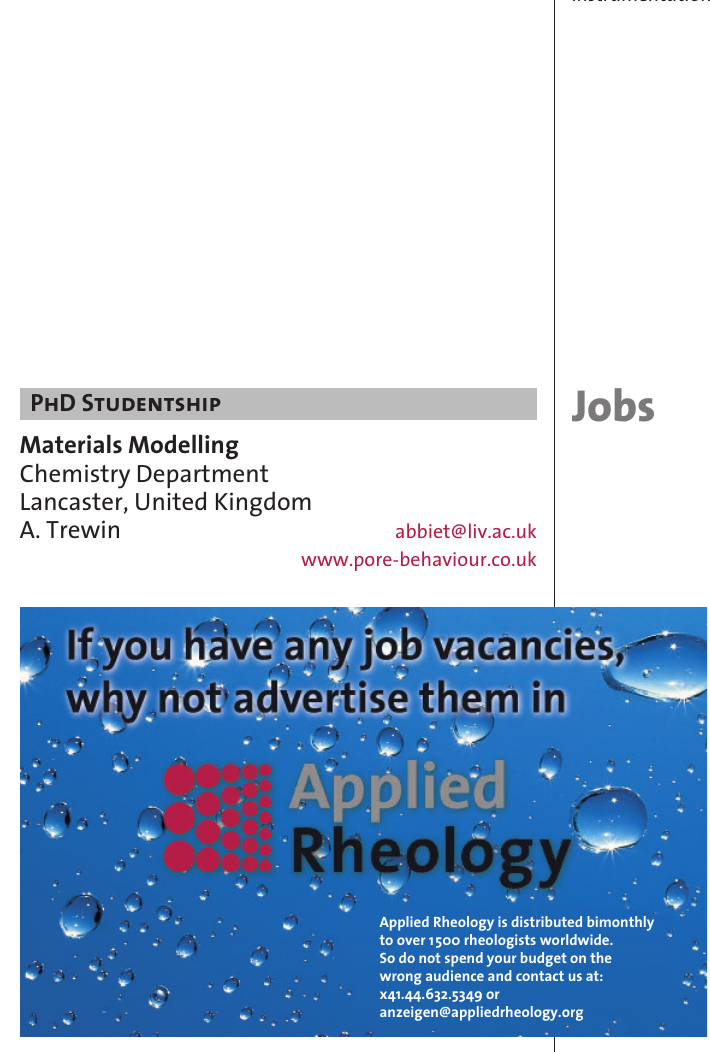
Figure 4 (left above): Refreshment during the coffee break. Figure 5 (right above): Dinner (from left Girish Gal- gali, Paula Wood-Adams, Clemens Holzer, Jeffrey Gia- comin, and Savvas Hatzikiri- akos). Figure 6 (left below): Poster section. Figure 7 (right below): Exhibition of scientific